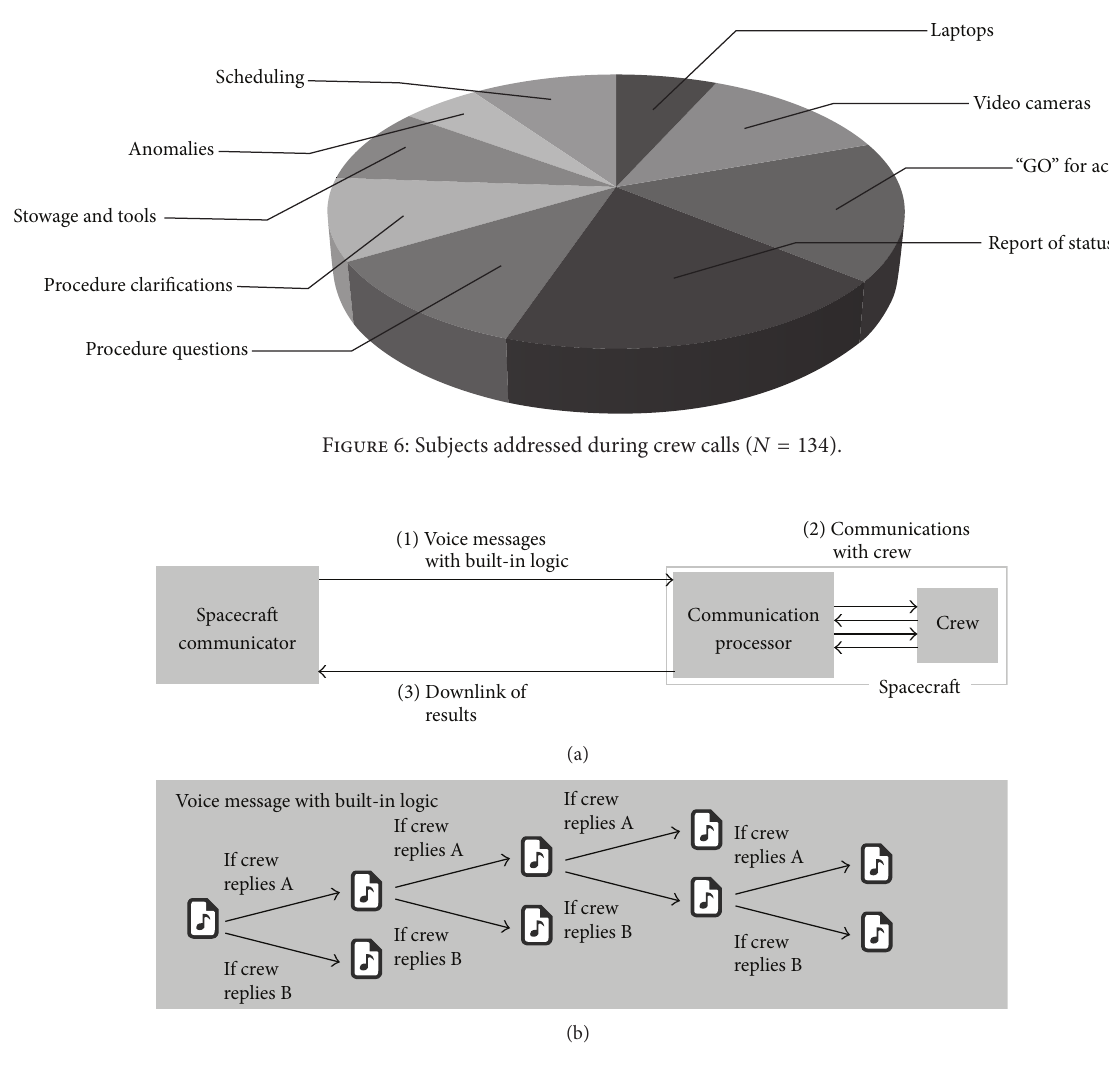
Figure 7: Potential communication approach for future